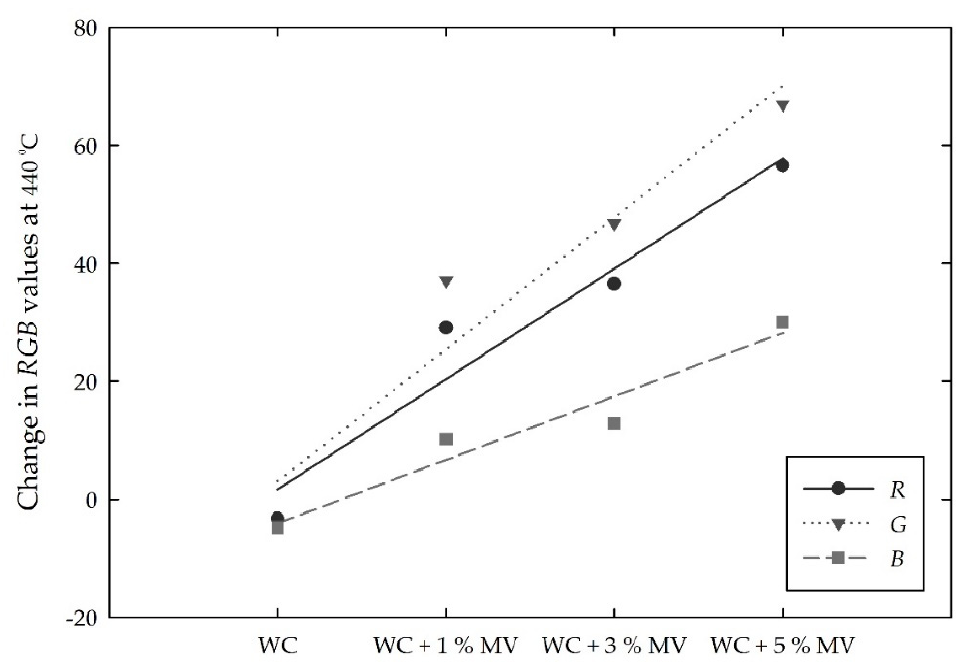
Figure 10. Comparisons of the RGB values for the white cement (WC) mixed samples with increasing temperatures: ( a ) R values; ( b ) G values; and ( c ) B values.